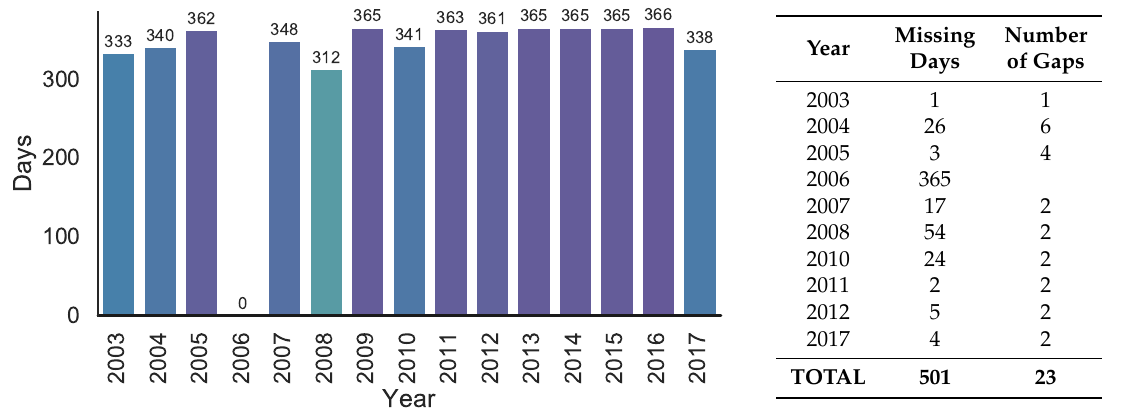
Figure 3. Yearly distribution of the daily observation files logged at Aboa between 1 February